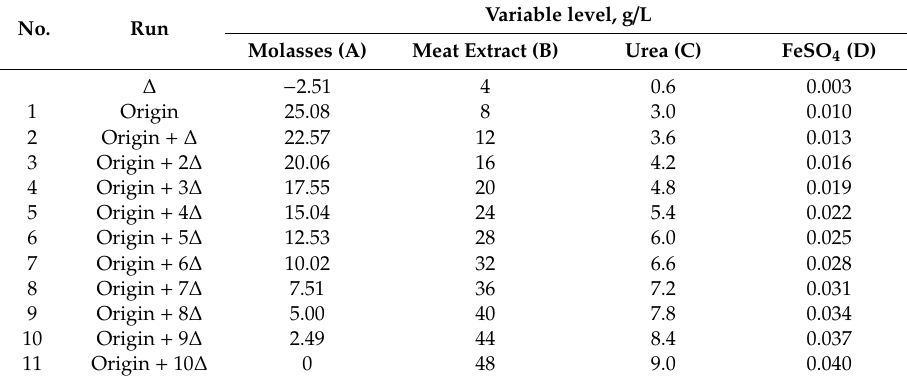
Table 12. Steepest Ascent design for tryptophan production by P. acidilactici